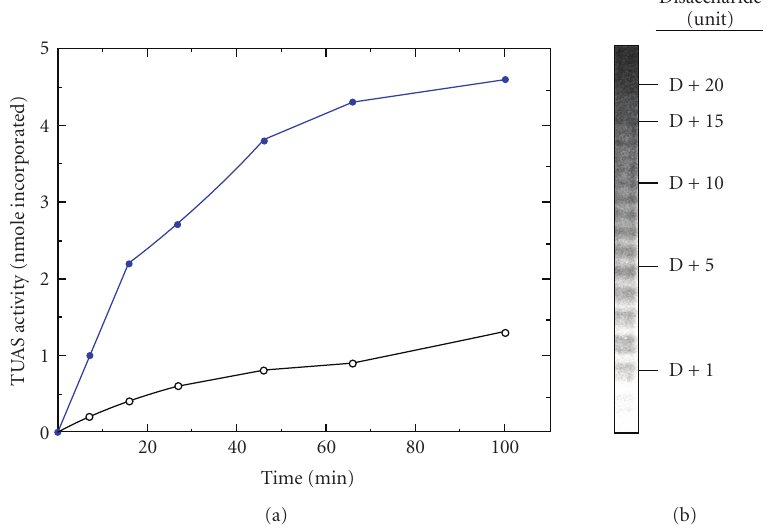
Figure 2: (a) E ff ect of the two substrates (UDP-[ 14 C]glucose and UDP-ManNAcA) on the activity of teichuronic acid synthetase (TUAS). Open circle: with one substrate 0.5mM UDP-C 14 -Glucose; Closed circle: two substrates by adding 0.5 mM UDP-ManNAcA to the same mix. (b) Analysis of teichuronic acid, the enzymatic product of TUAS, by nondenaturing PAGE stained with Alcian blue and silver. The numbers on the right represent the repeats of the basic TUA disaccharide unit. D is an oligosaccharide of TUA estimated to have 6–10 disaccharide repeats, which is not detectable by